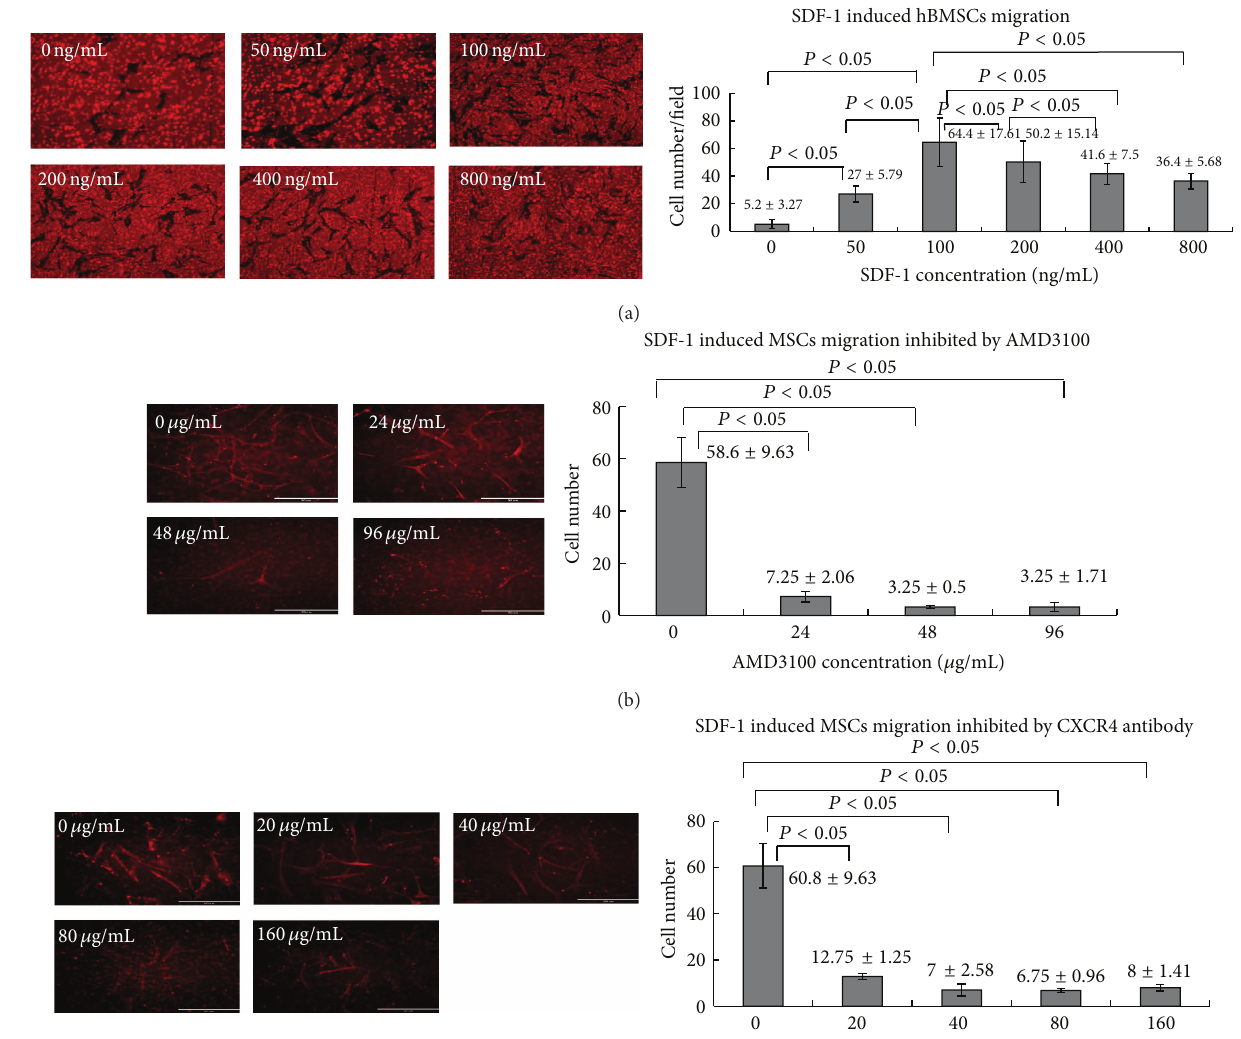
Figure 2: SDF-1 induces BMSCs migration in vitro . (a) SDF-1 at different concentration; the migrated cells were observed under fluorescence microscope and the graph indicated the number of migrated cells; (b) SDF-1 at 100 ng/mL; AMD3100 was added at different concentration, the migrated cells were observed and counted under fluorescence microscope and the graph indicated the number of migrated cells; (c) SDF-1 at 100 ng/mL; anti-CXCR4 antibody was added at different concentration, the migrated cells were observed and counted.